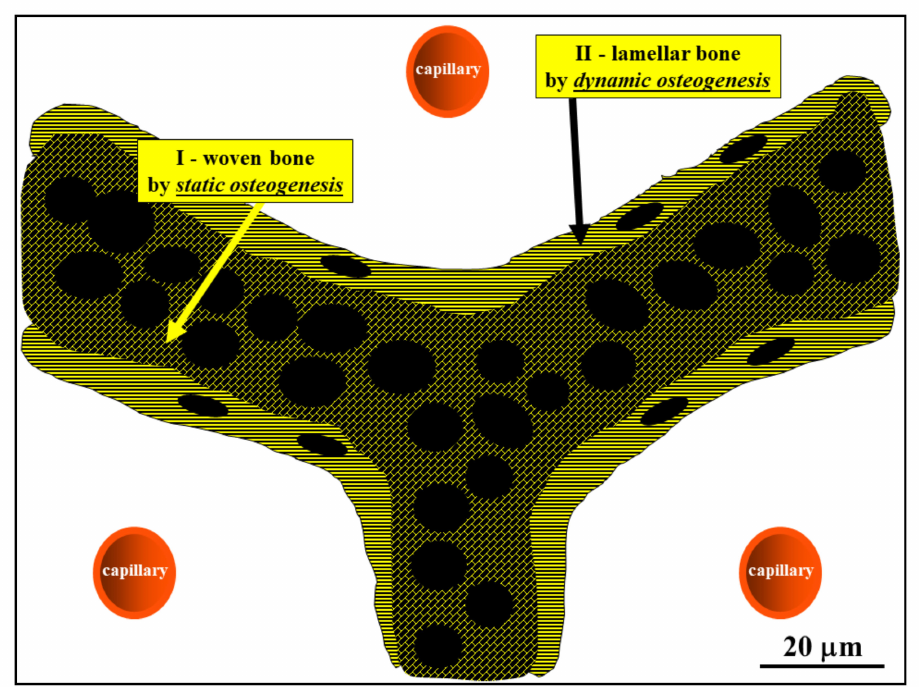
Figure 8. Schematic drawing showing the woven bone (by SO) forming the core of preliminary trabeculae for successive lamellar bone apposition by typical movable osteoblasts (in DO). (See SEM micrographs in Figure 5).